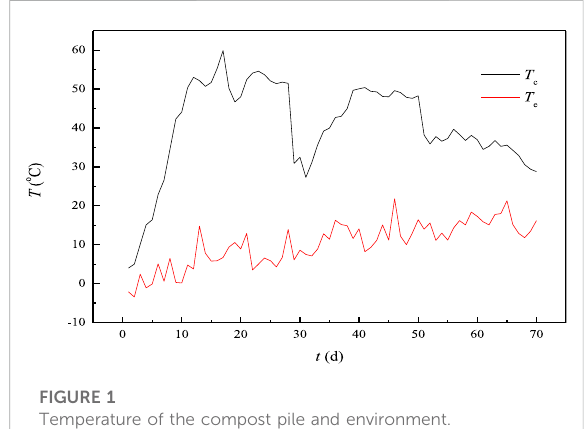
FIGURE 1 Temperature of the compost pile and